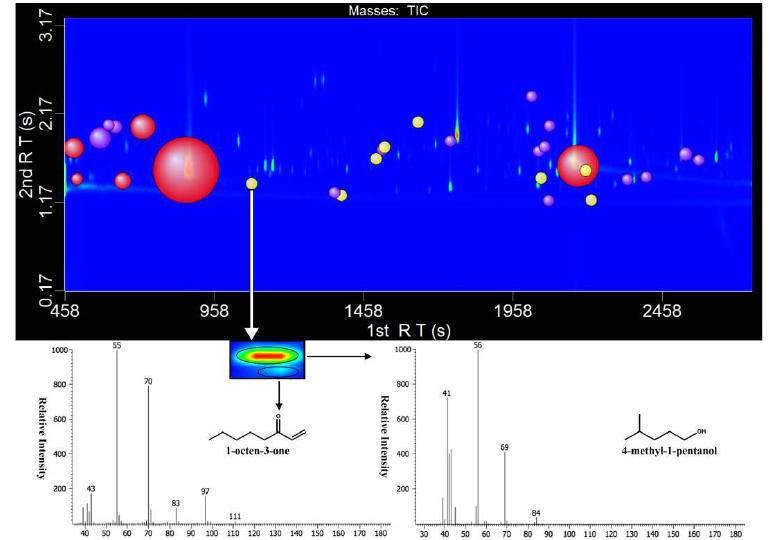
Figure 1. The quantitative compounds in a wine sample displayed using a two-dimensional gas chromatography and time-of-flight mass spectrometry (GC × GC-TOF-MS) contour plot. The size of the bubble represented the relative intensity of the compound’s quantitative ion response, and the minimum size of the bubble was set for clarity. The quantitative compounds were marked by bubbles and the bubbles with different colors represented different concentration ranges. Red bubbles: greater than 1000 μg/L, purple bubbles: between 10 and 1000 μg/L, yellow bubbles: less than 10 μg/L.